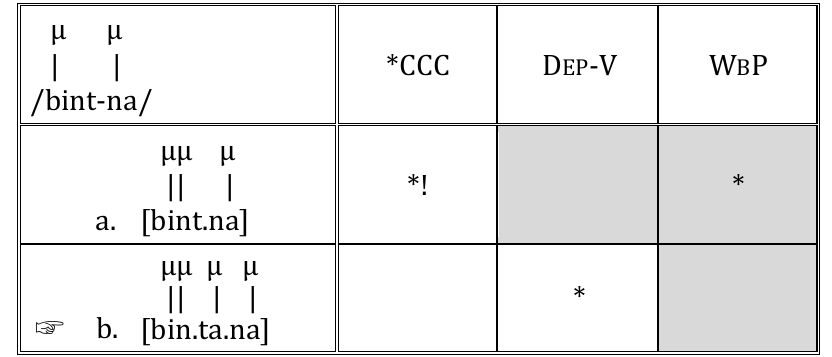
Tableau 6: *CCC prevents /bint-na/ from surfacing